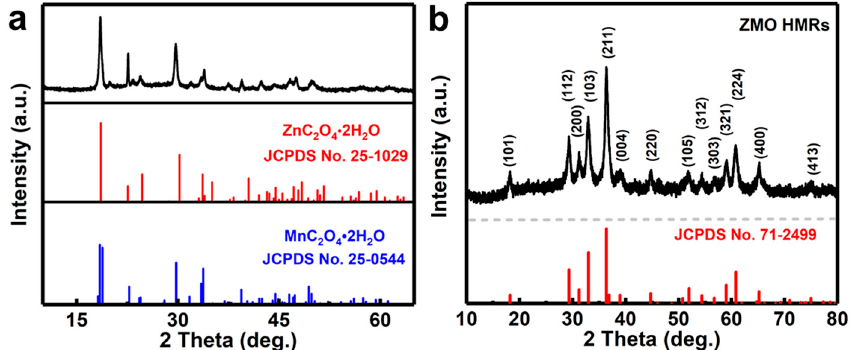
Figure 1. XRD patterns of the ( a ) ZnC 2 O 4 -MnC 2 O 4 ·2H 2 O precursor and ( b ) ZMO HMRs.